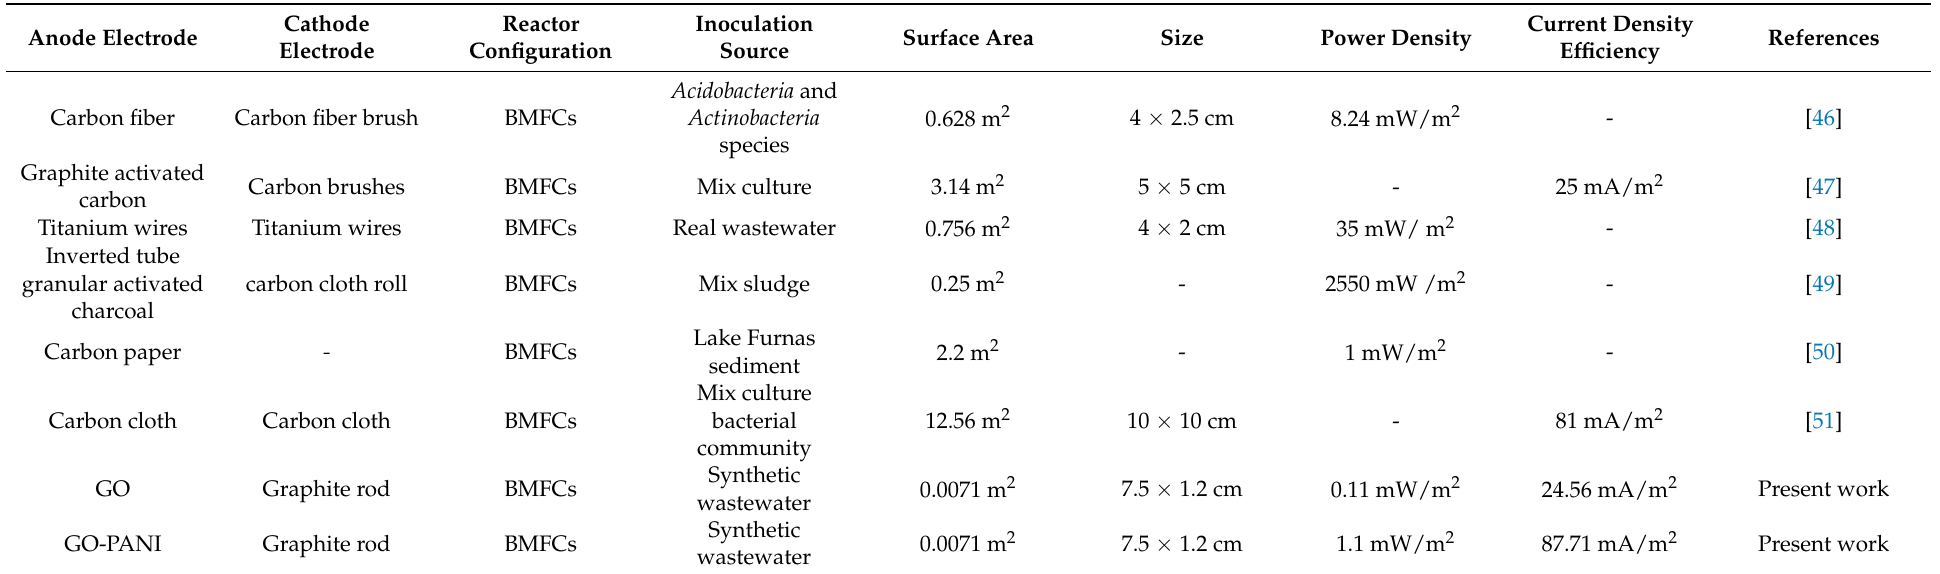
Table 2. A comparative summary of the anode electrodes in benthic microbial fuel cells